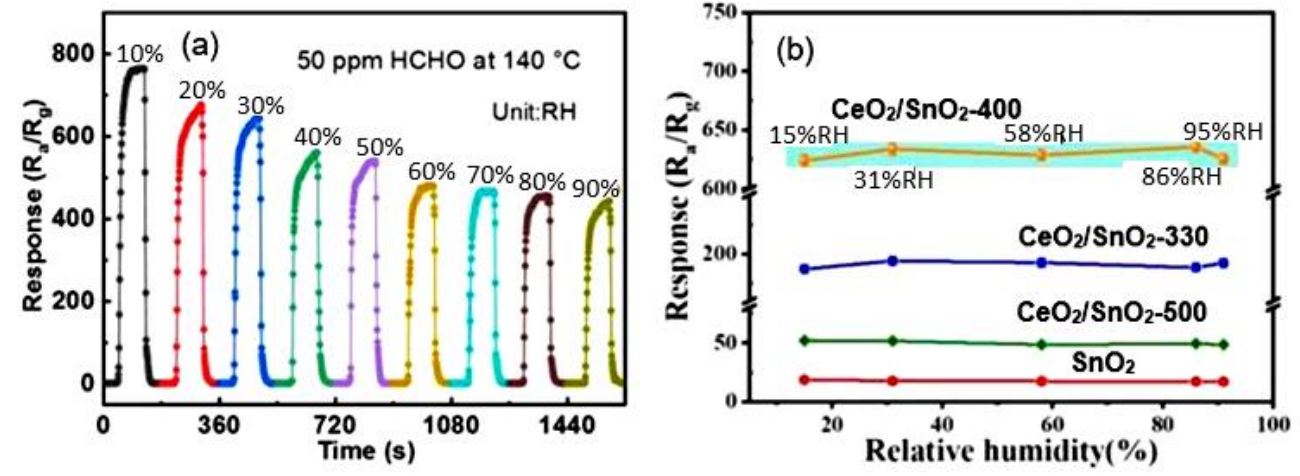
Figure 16. ( a ) Response-recovery curves of SnO 2 porous nanosheet-based sensor to HCHO under different RH. Zhu et al. [94]. Copyright 2021. Elsevier. ( b ) Relationship between relative humidity and response of porous CeO 2 -SnO 2 nanosheet-based sensor towards 3-hydroxy-2-butanone, a biomarker for pathogenic bacterium Listeria monocytogenes: 330, 400, and 500 correspond to the annealing temperature. Reprinted with permission from Yang et al. [92]. Copyright 2022: Elsevier.